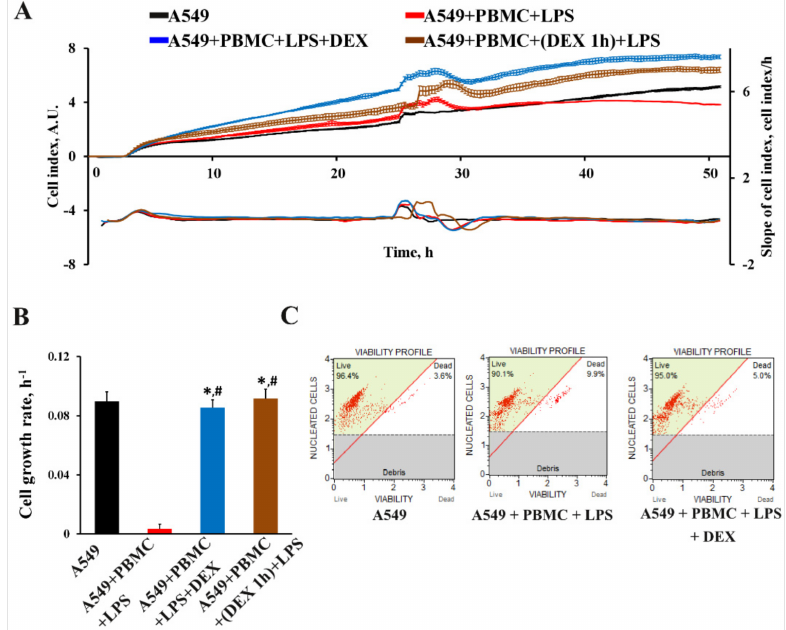
Figure 5. The effect of dexamethasone on the cell index and death of A549 cells within 24 h in a model system. The real-time curve of cell index for A549 cells ( A ) and quantification of the cell growth rate ( B ) measured using the RTCA iCELLigence for 35–50 h. ( C ) Cell death of A549 cells estimated using the Muse ® Count & Viability kit. A549 cells were collected 24 h after coculti- vation with activated PBMC, and the viable cells were estimated using the MUSE Cell Analyzer (Merck Millipore, Burlington, MA, USA). The data are presented as a mean ± SEM, n = 3. * p < 0.05 vs. A549 + PBMC + LPS, # p < 0.05 vs. A549 cells as determined by one-way ANOVA with Tukey’s multiple comparisons